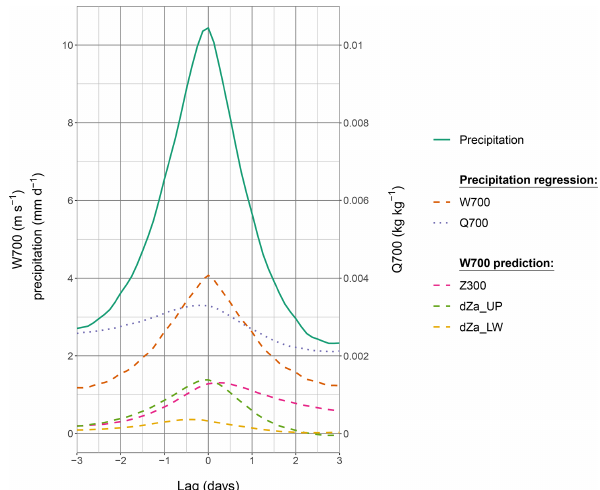
Figure 7. Lead/lag composite around the 10% highest values of UV700, as in Figs. 3, 4, and 5, for ERA5 precipitation, contribu- tions to precipitation based on moisture transport (UV700, Q700; see Sect. 3.1), and partial prediction of UV700 based on geopo- tential (Z300) and the geopotential thicknesses anomaly (dZa_UP and dZa_LW; see Sect. 3.2). Note that Z300, dZa_UP, and dZa_LW have the same units as UV700 and, with the intercept, add up to the prediction of UV700 ( (cid:92) UV700; see Eq.